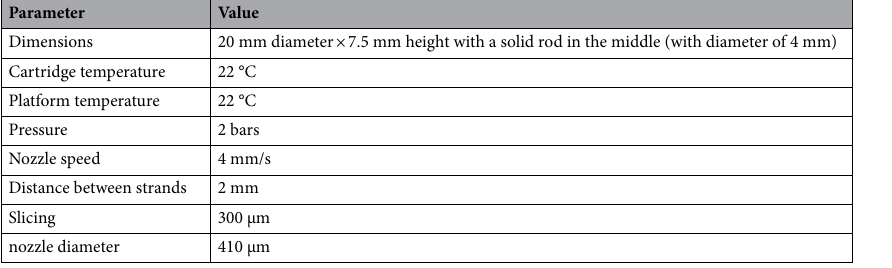
Table 1. Parameters used in 3D printing of the bone portion of the